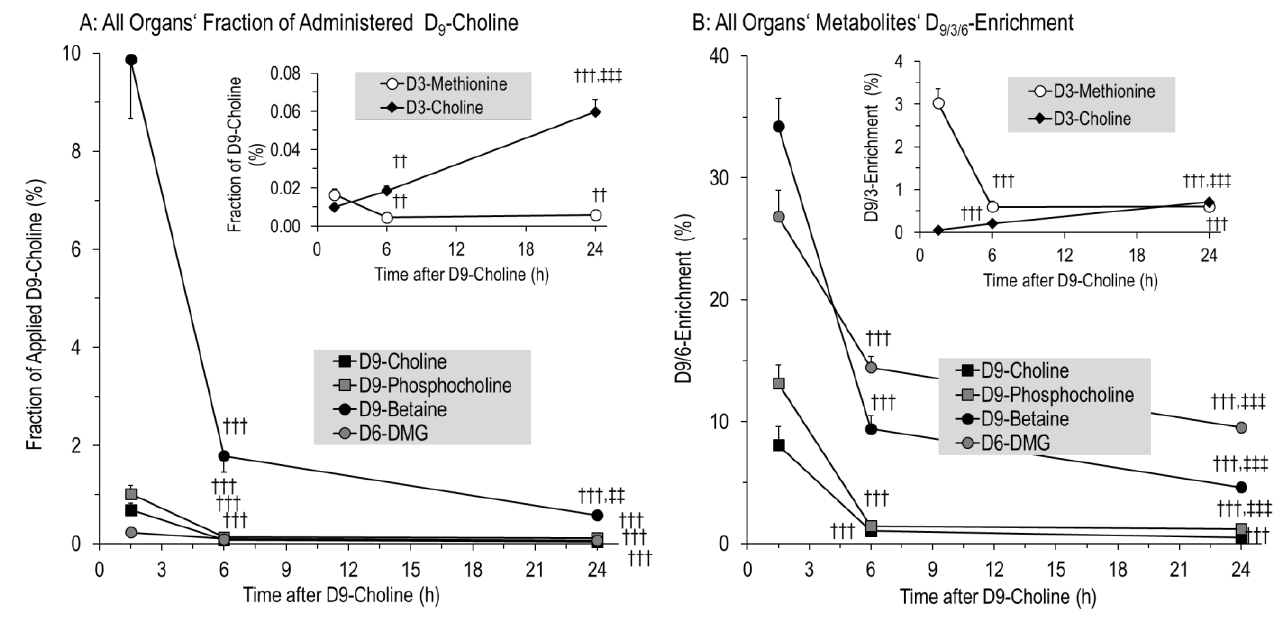
Figure 2. Fraction of administered D9-choline ( A ) and deuterium enrichment ( B ) in water-soluble components of the sum of all investigated organs. Fractions of administered D9-choline ( A ) were corrected for the number of deuterated methyl groups in the respective components, which are 2 for D6-dimethylglycine (D6-DMG), and 1 for D3-methionine and D3-choline. Data are means ± SE of 8–10 data points per time point (1.5 h, 6 h, 24 h). Abbreviations: ††, p < 0.01, †††, p < 0.001 vs. 1.5 h; ‡‡, p < 0.01, ‡‡‡, p < 0.001 vs. 6 h.